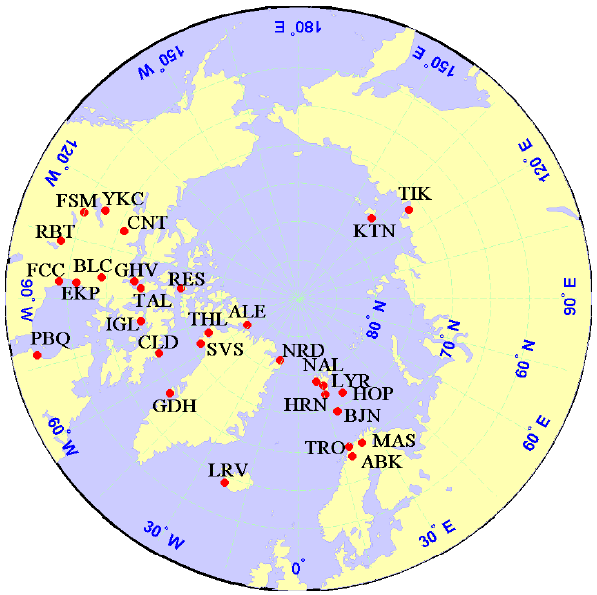
Fig. 1. A map with the station positions in geographic